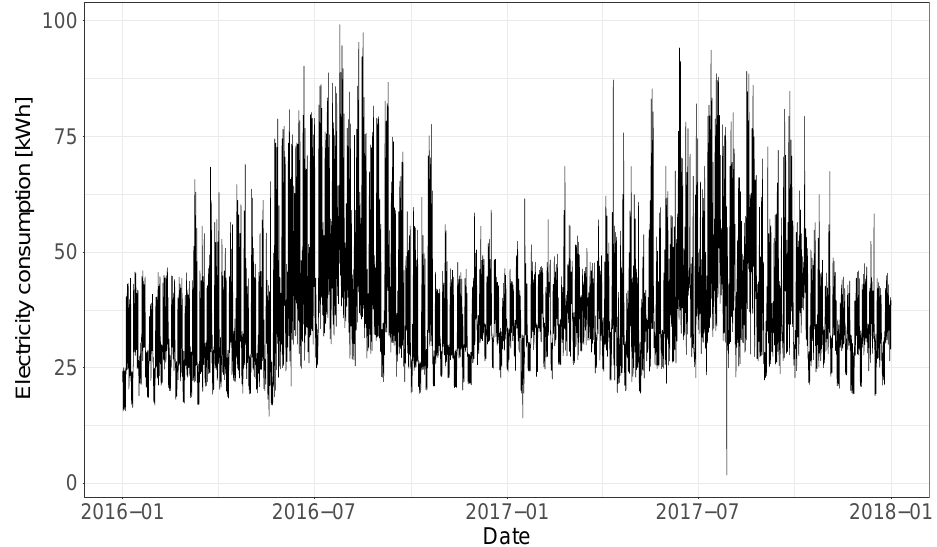
Figure 10. Electricity consumption time-series for the building Rat_health_Gaye